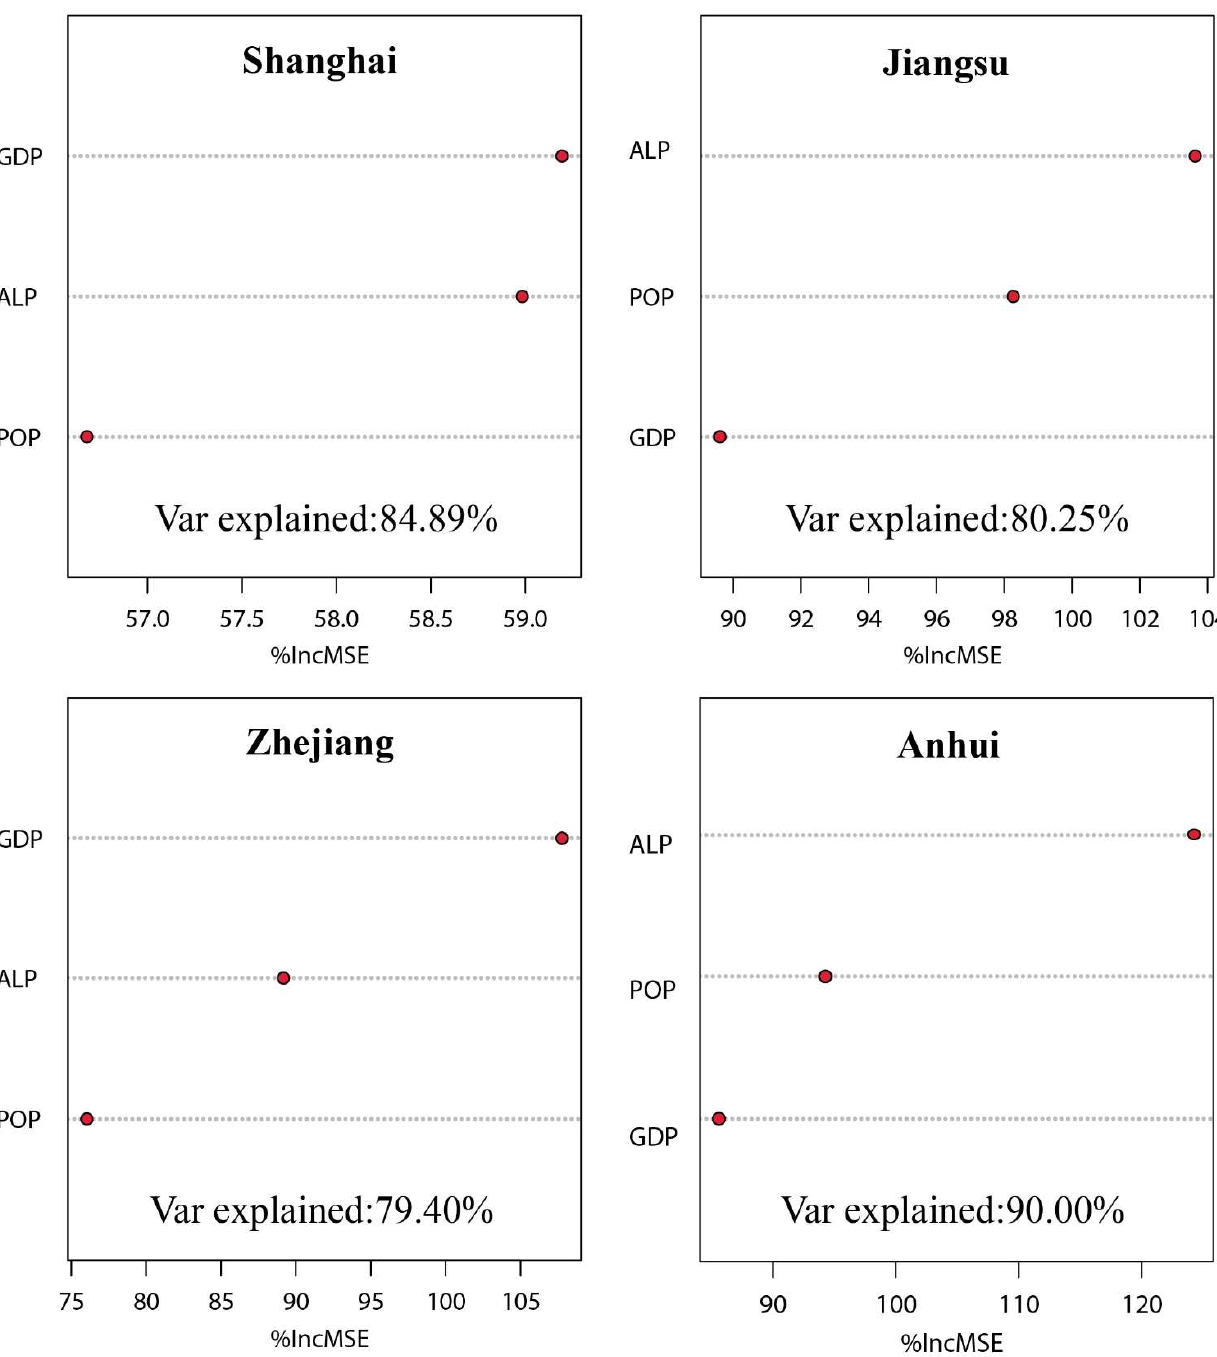
Figure 7. Sensitivity of CSDR to urbanization indicators in different regions in 2020.